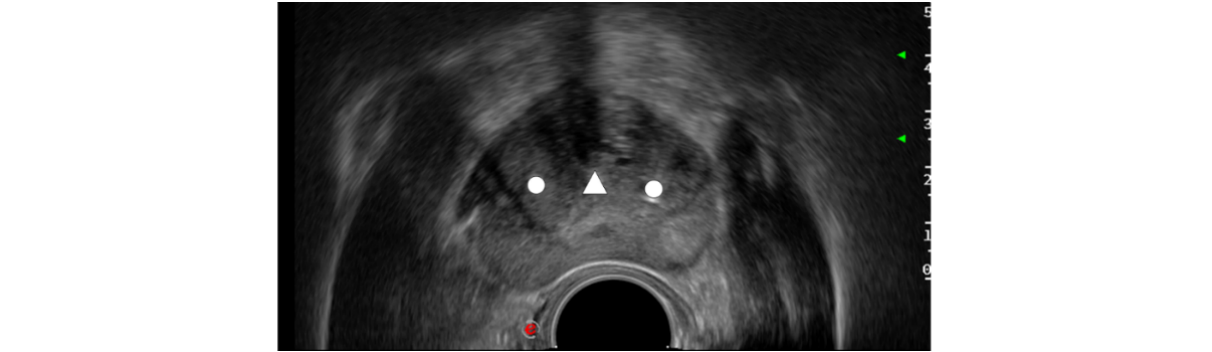
Figure 3. Transverse plane ultrasound image of the prostate. Fibres (circles) positioned in both transition zones while maintaining a safe distance from the urethra (triangle), rectum and prostatic